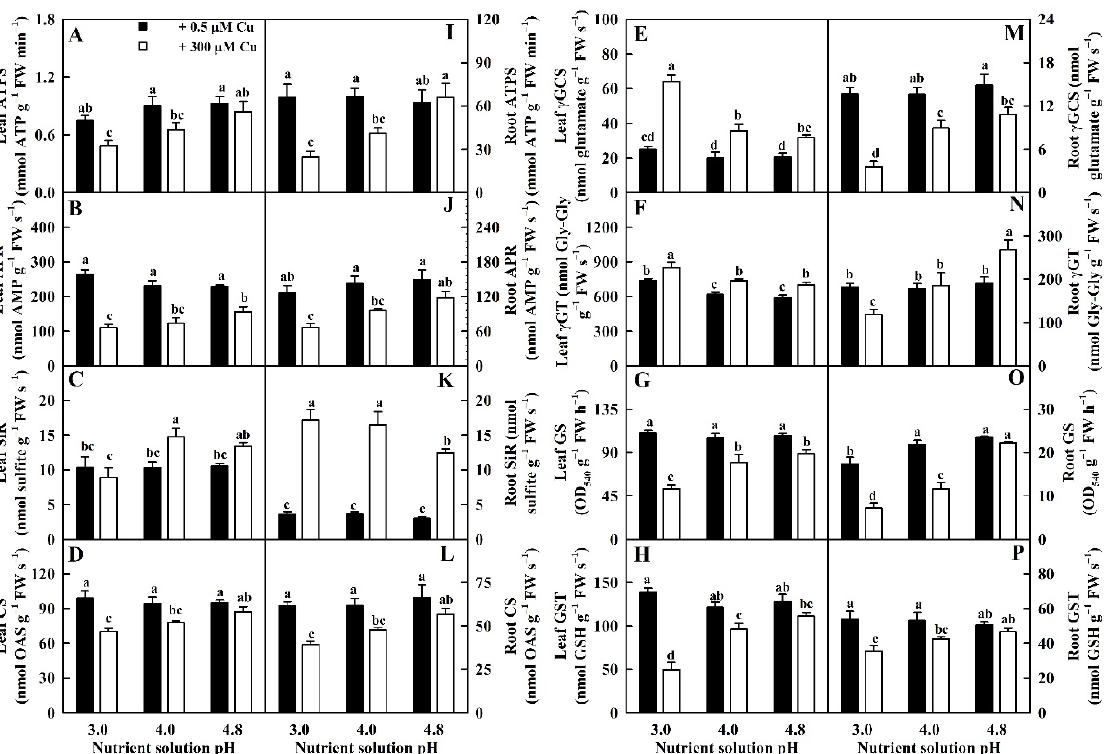
Figure 3. Impacts of Cu–pH interactions on the activities of ATPS ( A , I ), APR ( B , J ), SiR ( C , K ), CS ( D , L ), γ GCS ( E , M ), γ GT ( F , N ), GS ( G , O ), and GST ( H , P ) in leaves and roots. Bars represent means ± SE ( n = 4). Different letters above the bars indicate a significant difference at p < 0.05. Gly-Gly, glycylglycine; OAS, O-acetylserine.